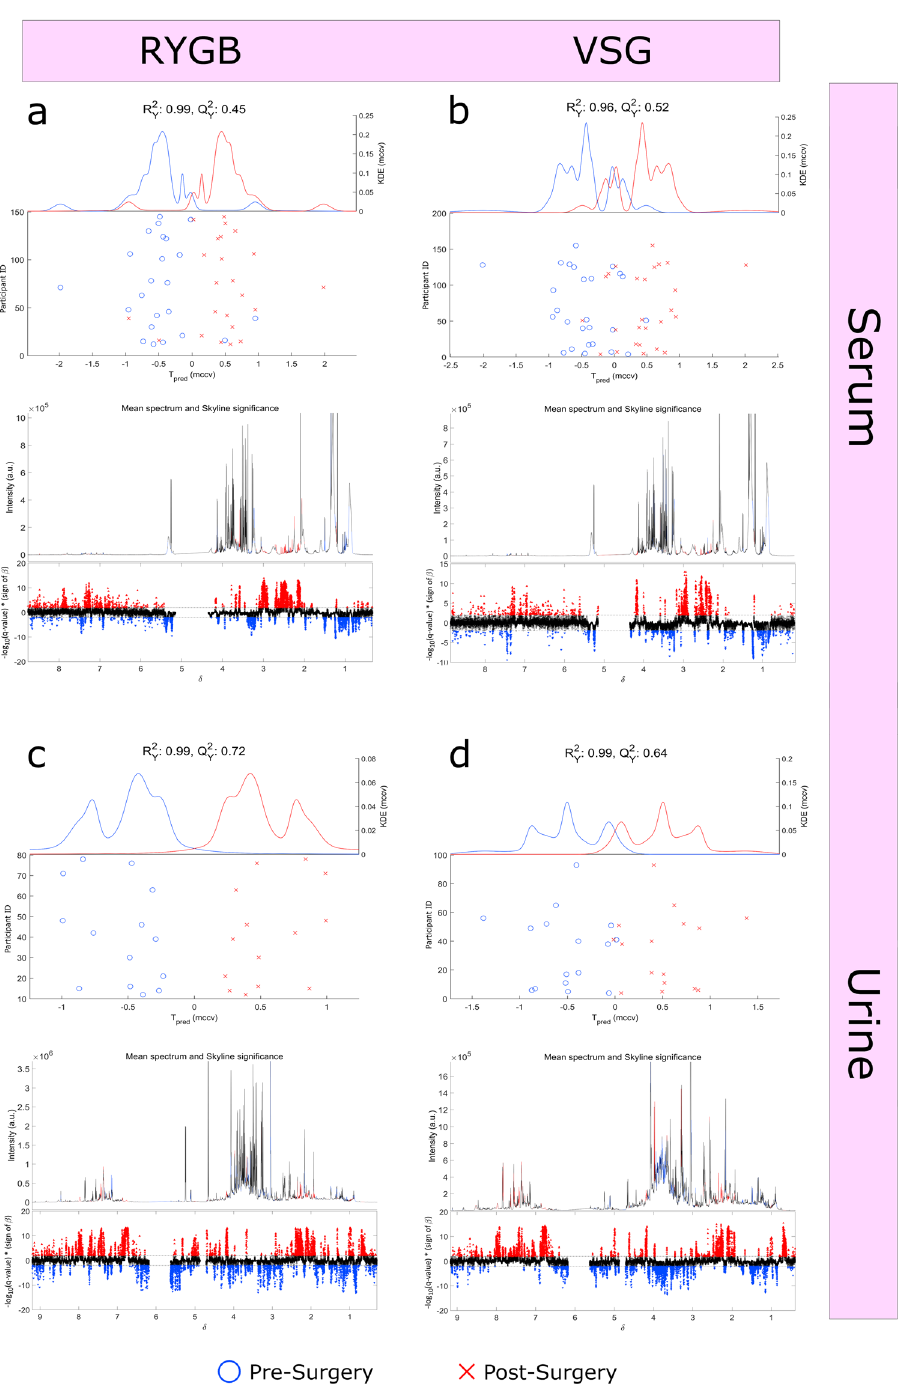
Fig. 5 Metabolite changes after RYGB and VSG procedures, assessed by 1 H-NMR spectroscopy. Repeated Measures, Monte-Carlo Cross-Validation, Partial Least Squares Discriminant Analysis (RM-MCCV-PLSDA) models were generated using 1 H – Nuclear Magnetic Resonance ( 1 H-NMR) spectra derived from serum and urine bio fl uids pre and 3-months post Roux-en-Y Gastric Bypass (RYGB) and Vertical Sleeve Gastrectomy (VSG) procedures. Model scores: ( a ) Serum RYGB ( n = 23, R 2 Y 0.99, Q 2 Y 0.45), ( b ) Serum VSG ( n = 26, R 2 Y 0.96, Q 2 Y 0.52), ( c ) Urine RYGB ( n = 14, R 2 Y 0.99, Q 2 Y 0.72), ( d ) Urine VSG ( n = 16, R 2 Y 0.99, Q 2 Y 0.64), (Supplementary Fig. 9a) Faeces RYGB ( n = 10, R 2 Y 0.94, Q 2 Y 0.06), (Supplementary Fig. 9b) Faeces VSG ( n = 14, R 2 Y 0.98, Q 2 Y 0.66). Upper panels: RM-MCCV-PLSDA scores plots comparing participant samples pre and 3-months post bariatric surgery. Models are comprised of 1 predictive and 1 orthogonal component. Lower panels: Mean 1 H-NMR spectrum and Manhattan plot. Manhattan plot showing -log 10 (pFDR) x sign of the variable regression coef fi cient ( β ) for each variable within the RM-MCCV-PLSDA model. Dotted lines illustrate the pFDR signi fi cance cut off level (0.01) on the log 10 scale. Spectra considered signi fi cant are highlighted in the Manhattan plot and mean spectrum. Red metabolites ( 1 H-NMR signals) are signi fi cantly increased post-surgery, blue metabolites ( 1 H-NMR signals) are signi fi cantly decreased post-surgery.